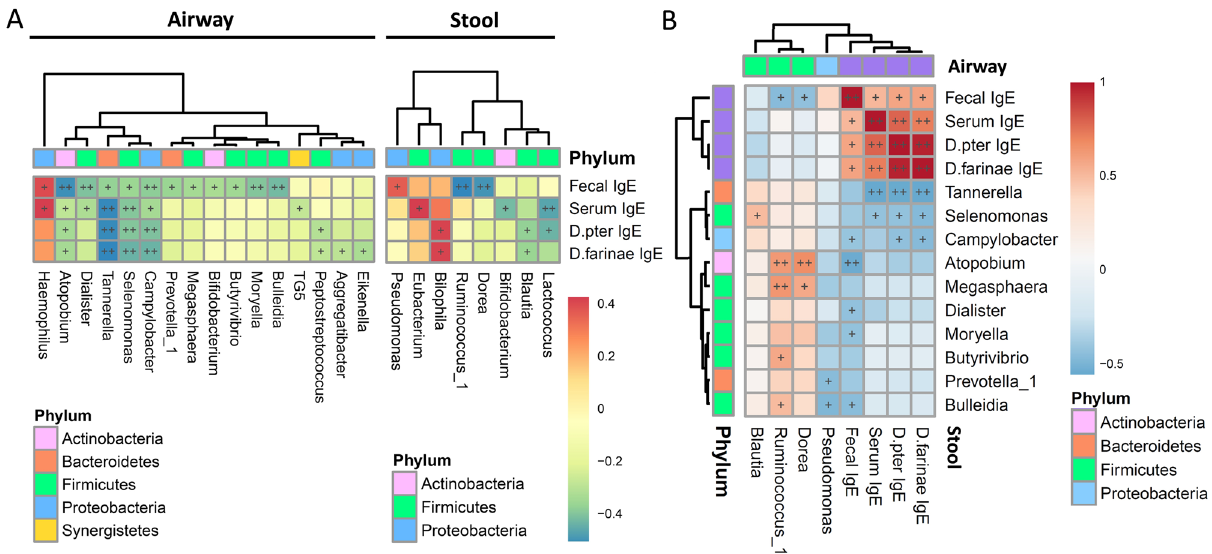
Figure 3. Heatmap of Spearman’s rank correlation coefficients between airway and stool microbiota associated with total fecal IgE and serum mite-specific IgE levels. Airway and stool genera of bacteria significantly correlated with fecal and serum IgE levels ( A ). FDR-adjusted correlations between IgE-related airway and stool genera of bacteria, and fecal and serum IgE levels ( B ). Color intensity represents the magnitude of correlation. Red color represents positive correlations; blue color represents negative correlations. + symbol means a P -value < 0.05; ++ symbol means a P -value <